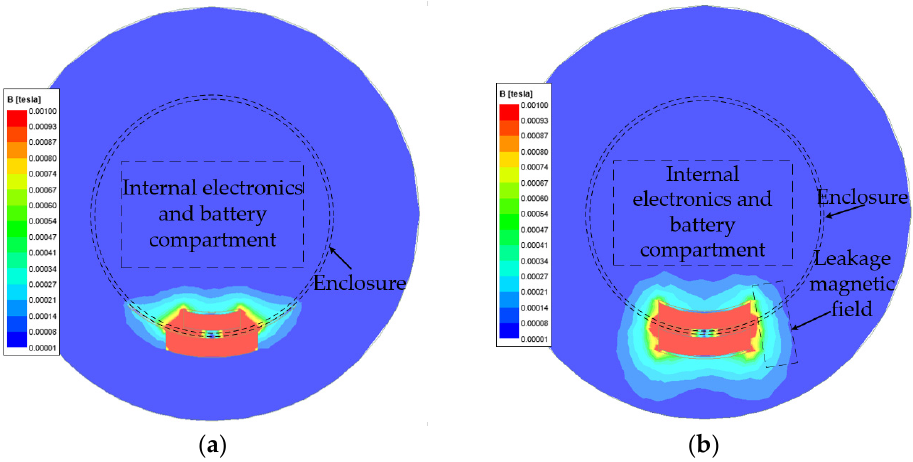
Figure 5. Static magnetic field clouds of two structures. ( a ) Arc-shaped core; ( b ) Double dipole core.